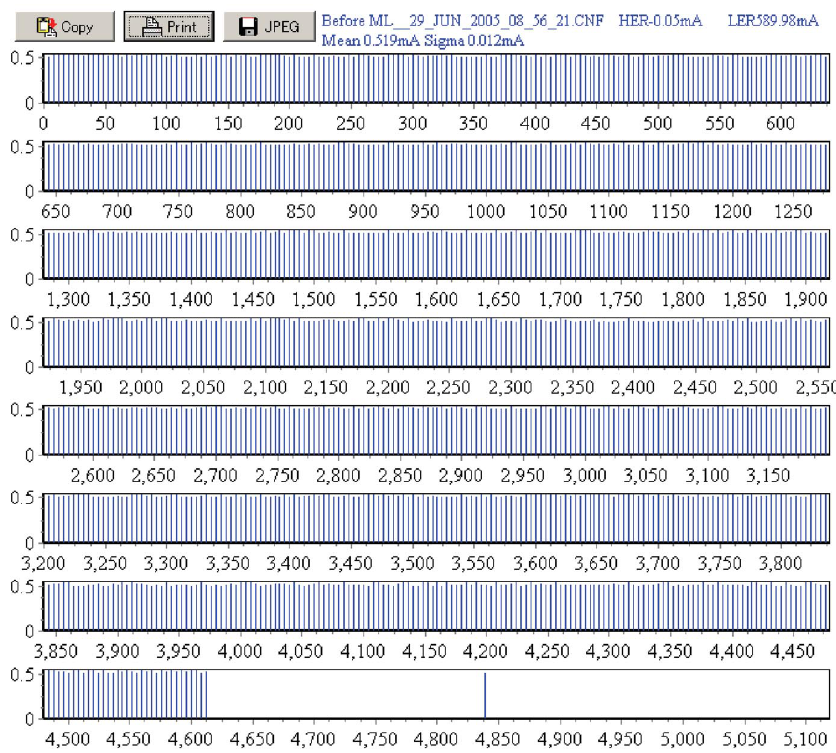
FIG. 1. (Color) Typical filling pattern during